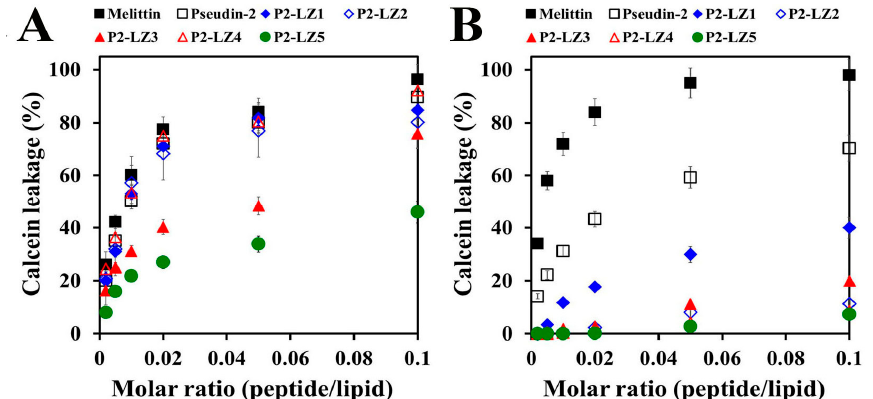
Figure 7. Membranolytic action of pseudin-2 and P2-LZ peptides in artificial liposomes. Calcein leakage from PC/PE/PI/ergosterol (5:4:1:2, w / w / w / w ) ( A ) and PC/CH/SM (2:1:1, w / w / w ) ( B ) liposomes after the addition of the peptides at the indicated molar ratios. Data are expressed as the means ± standard deviation from three independent experiments.